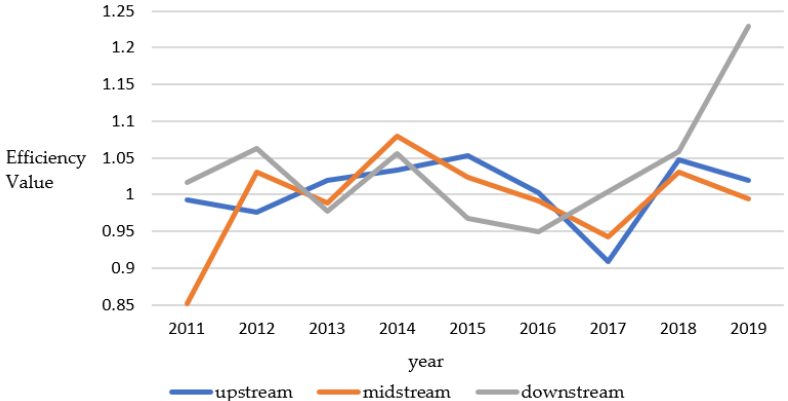
Figure 1. Line graph of the results of high-quality development efficiency measurement in the Yellow River sub-basin.